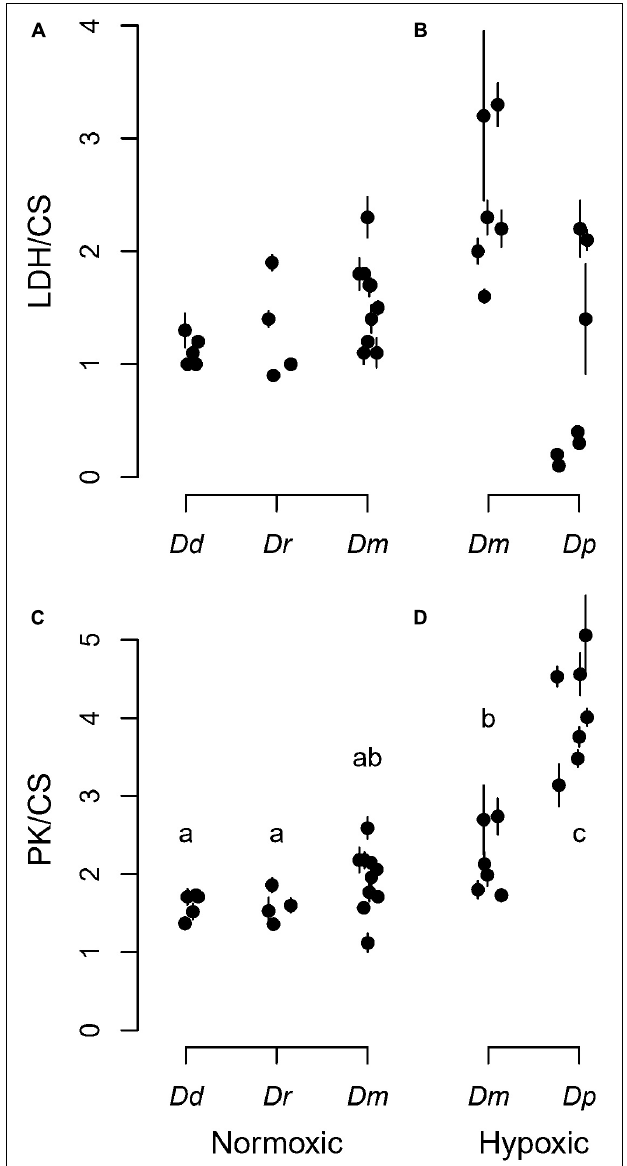
FIGURE 2 | Glycolytic enzyme activities across species and lake type. The top row shows lactate dehydrogenase (LDH) relative to the housekeeping gene citrate synthase (CS) for each (A) normoxic or (B) hypoxic lake. The bottom row shows pyruvate kinase (PK) relative to the housekeeping gene citrate synthase (CS) for each (C) normoxic or (D) hypoxic lake. Solid circles are individual lakes, and vertical bars are ± SD from six replicates. Daphnia species are identified in Figure 1 . Data points are jittered horizontally to avoid visual overlap within a lake category. Different letters indicate significant differences ( p <